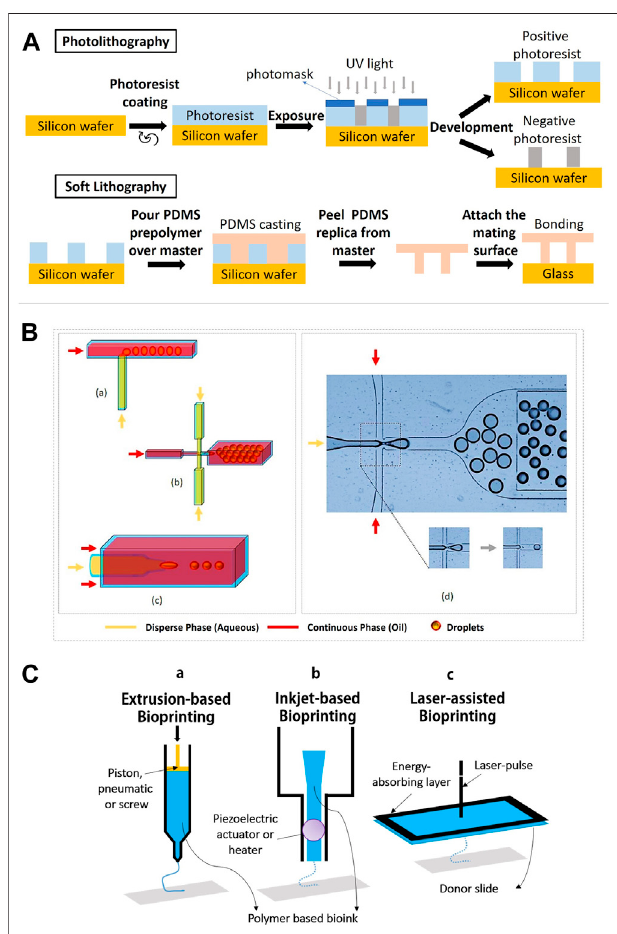
FIGURE 4 | Lithography, micro fl uidics and bioprinting methods for stem cell microencapsulation. (A) Schematic diagram shows the process of photolithography and soft lithography. (B) Geometric illustrations of three micro fl uidic devices: (a) T-junction, the perpendicular fl ow of the continuous phase is sheared by dispersed phase and thereby generates droplets. (b) Flow-focusing, droplets are produced by shearing the dispersed phase from two directions. (c) Co- fl ow, the dispersed phase is forced through a capillary inside a bigger capillary where continuous phase is pumped. (d) Droplet generation by fl ow-focusing device (use of fl uorinated oil with stabilizing agent and dispersed phase as water solution of dye). Figure adapted with permission from Figure 1 of (Hayat et al., 2018; Alkayyali et al., 2019). (C) Schematic diagram of (a) piston extrusion-based bioprinting, (b) piezoelectric actuator inkjet-based bioprinting, and (c) laser-assisted bioprinting.